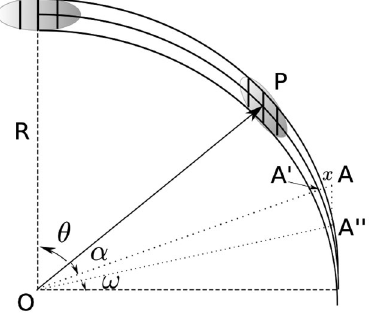
FIG. 13. Trajectories (solid curves) of three beam particles which are initially at the center of the beam and separated by equal distance vertically. Their trajectories are arcs with the same curvature but shifted in the vertical direction by the initial separation distance. Particles on a vertical line remain on a vertical line as shown but their relative position to the center of the beam P has changed. The center of the beam has rotated by an angle (cid:7) and a particle at point A nearby can be described by the accelerator coordinates ð (cid:4); x Þ or ( (cid:13) (cid:12) (cid:4)R , x ). Before entering the magnetic bend, the Cartesian coordinates of this particle relative to the beam (cid:12) PA 00 _ , x (cid:12) AA 00 ). A 0 , A 00 are the intersections center is ( (cid:13) 0 0 of P ’s trajectory with OA and with AA 00 , respectively, where AA 00 is a vertical